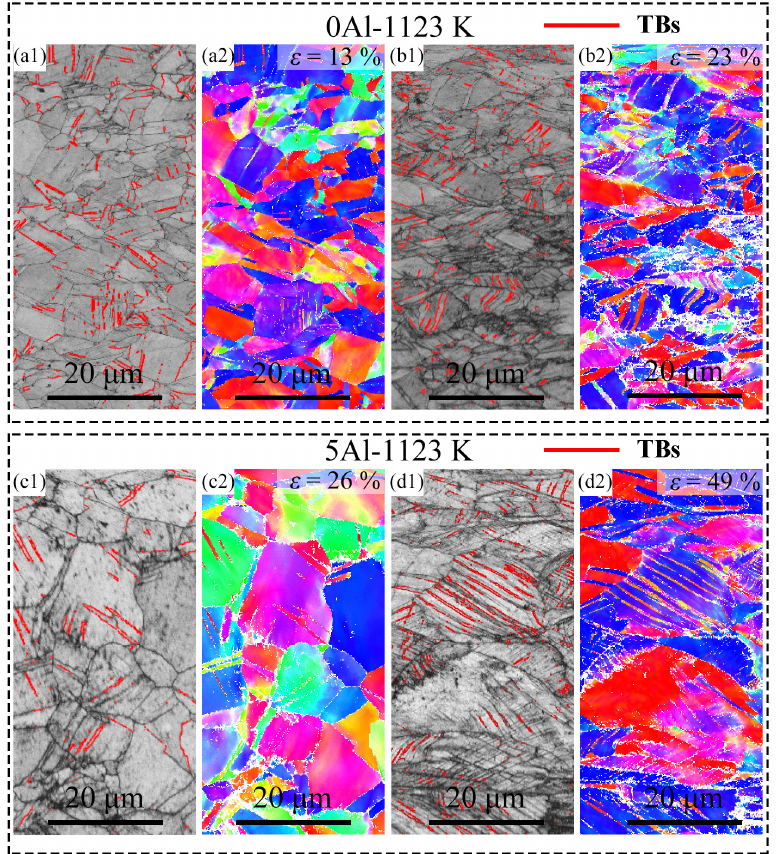
Figure 4. ( a1 , b1 ) EBSD IQ and ( a2 , b2 ) IPF maps of the 0Al ‐ 1123 K samples at different local strains and ( c1 , d1 ) EBSD IQ and ( c2 , d2 ) IPF maps of the 5Al ‐ 1123 K samples at different local strains.